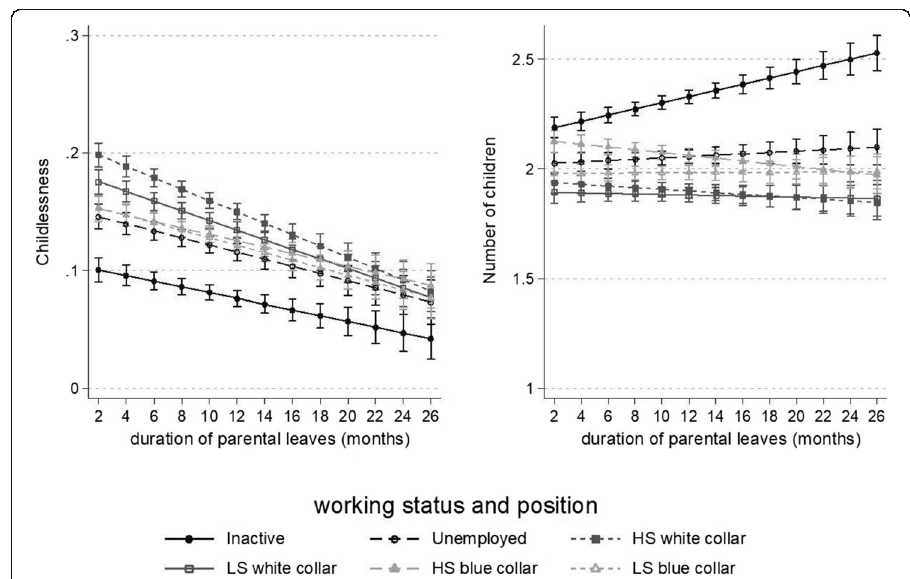
Fig. 1 Predicted probabilities of being without children (left) and predicted number of children (right) by length of parental leave and women's working status and position. Source : EU-LFS 2005-2010, author ’ s elaboration. Note : Predictions refer to Tables 10 and 11 in the Appendix, models C3a and N3a. 90% confidence intervals displayed